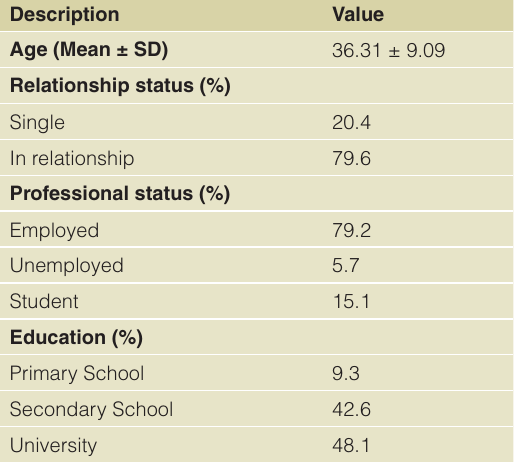
Table 1. Demographic characteristics of the respondents. Table 2. Descriptive statistics of patients diagnosed with delayed